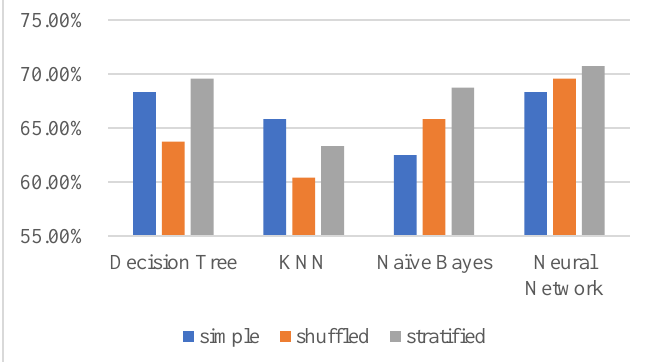
Fig. 4. Overall accuracy for actual crowd